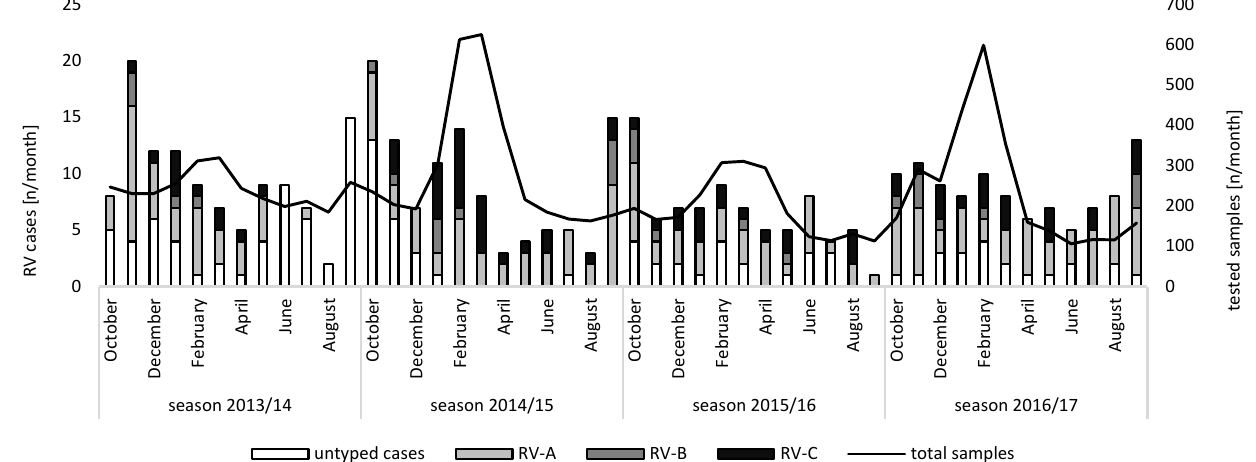
Figure 1. Monthly total numbers of tested samples and rhinovirus cases ( n = 410) stratified by species A, B, and C, as well as untypable rhinoviruses. Note the two different y-axes: the left axis shows the absolute numbers of detected Rhinovirus A, Rhinovirus B, and Rhinovirus C cases, as well as the absolute numbers of untyped cases, while the right axis shows the absolute number of tested samples. Table 1. Gender, age, and rhinovirus species distribution during the study period.